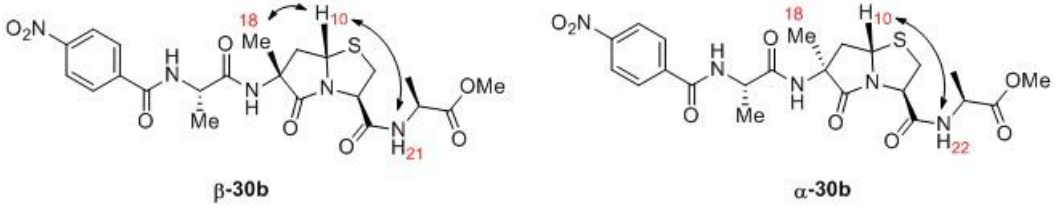
Figure 2. Selected Nuclear Overhauser enhancement (nOe) results from irradiation of diastereomeric 30b .